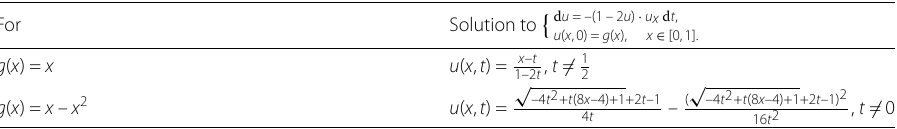
Table 1 Solution for the Lighthill-Whitham-Richards model for different g